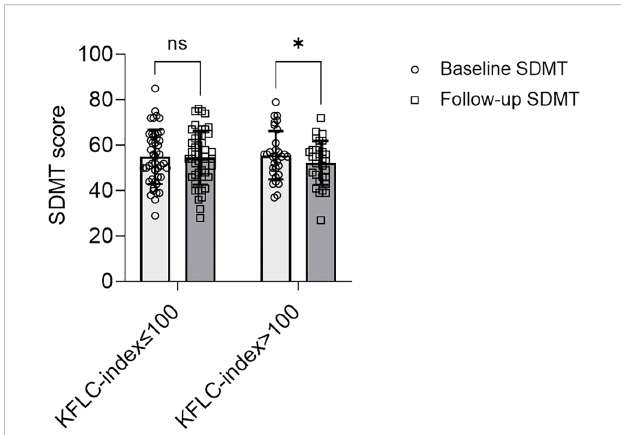
FIGURE 1 Interleaved scatter and bars plot with mean and standard deviation, showing SDMT scores at baseline compared to last follow-up in patients with relapsing-remitting multiple sclerosis strati fi ed by KFLC- index ≤ 100 (n=46) vs. KFLC-index>100 (n=31). Values at baseline and follow-up were compared with the Wilcoxon matched pairs signed-